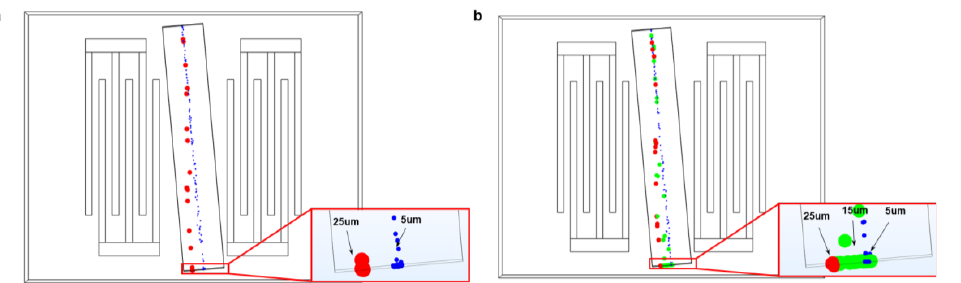
Figure 5. The particle trajectories of the single-stage SAW device with two different diameter particles ( a ) and with three different diameter particles ( b ).